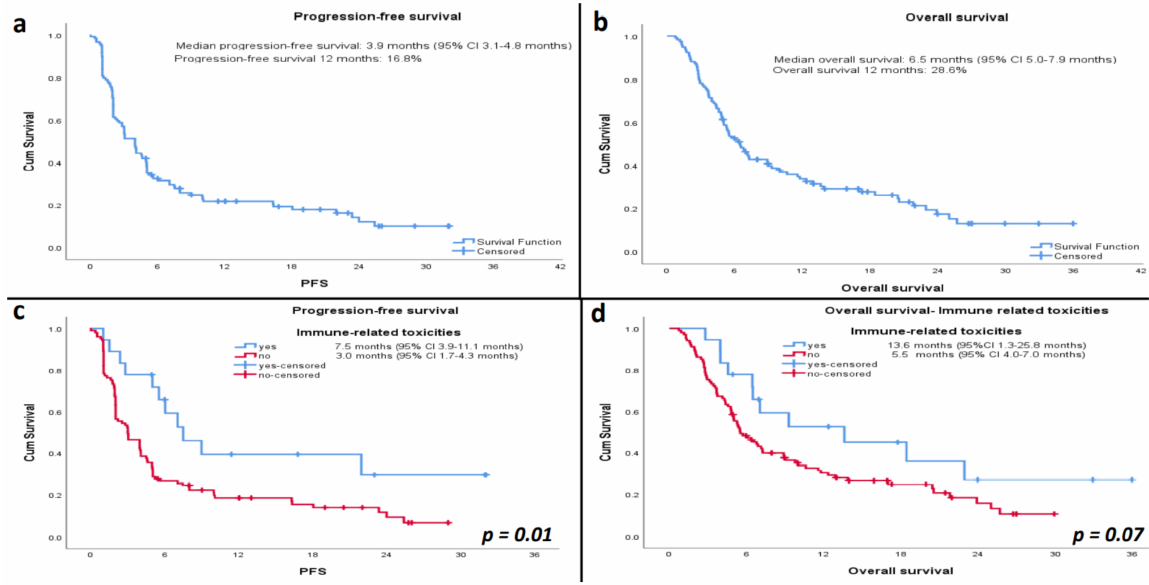
Figure 2. Kaplan–Meier curves for ( a ) progression-free survival and ( b ) overall survival. Kaplan–Meier curves for ( c ) progression-free survival and ( d ) overall survival in patients with or without immune-related toxicities